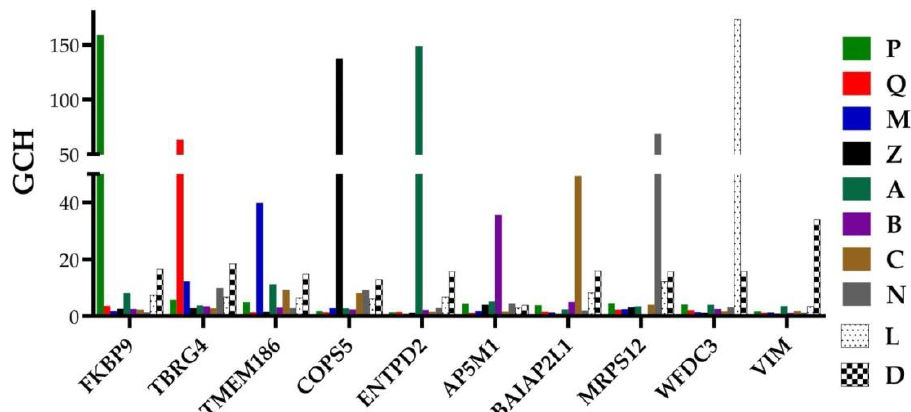
Figure 4. GMRs of the profiled regions from the prostates of the “PQMZ” and “ABCN” patients and from the cancer cell lines “L” and “D”. Note that the GCH scores in the other samples are substantially lower the score in the sample commanded by the GMR.